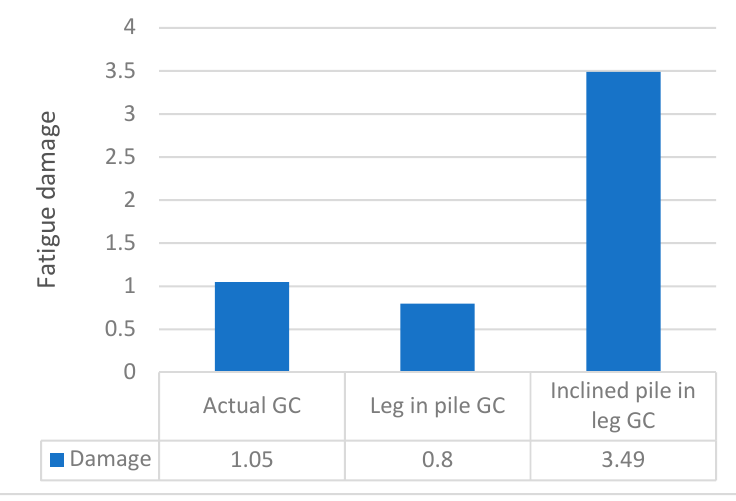
Figure 22. Effect of grouted connection on fatigue damage.